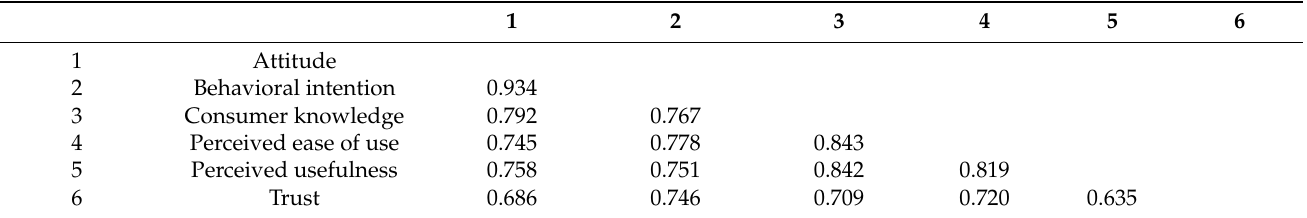
Table 5. Heterotrait–monotrait Ratio (HTMT).